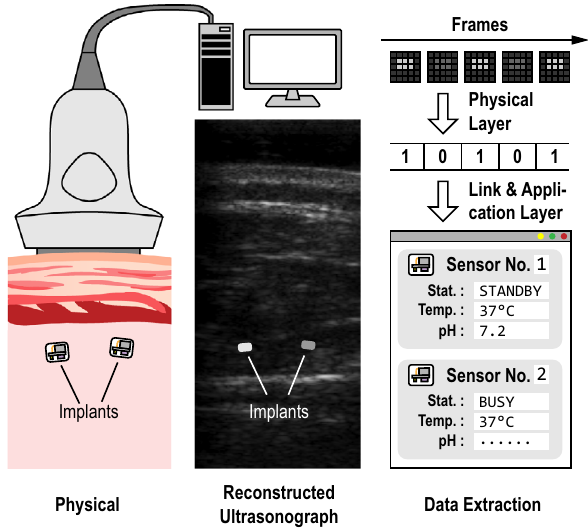
Fig. 1 CMOS mote implementing augmented ultrasonography. Illustration of a typical use case; after the motes are physically implanted, they can be identi fi ed in an ultrasonograph, and data can be transmitted bidirectionally between the imager and the mote to retrieve real-time physiological